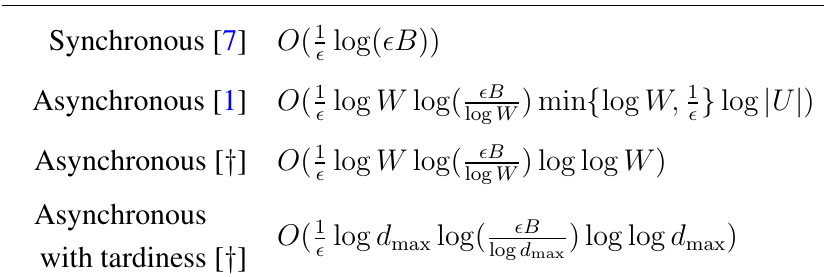
Table 1. The space complexity for answering (cid:15) -approximate frequent item set query in a sliding time window. Results from this paper are marked with [ † ]. Note that we assume log W ; otherwise, we can always store all items in the window for exact answer, B ≥ 1 (cid:15) log W ) words. Similarly, for the result with tardiness, we assume B ≥ 1 using O ( 1 (cid:15)